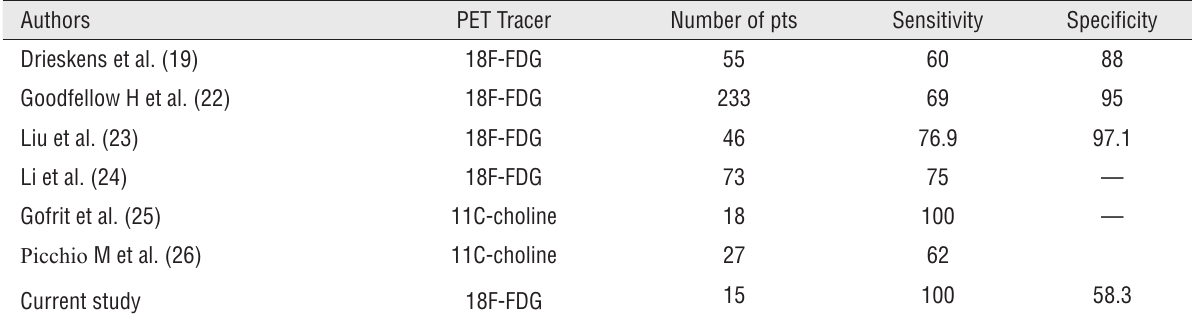
Table 3 - Contemporary series on role of pET/CT for pelvic nodal